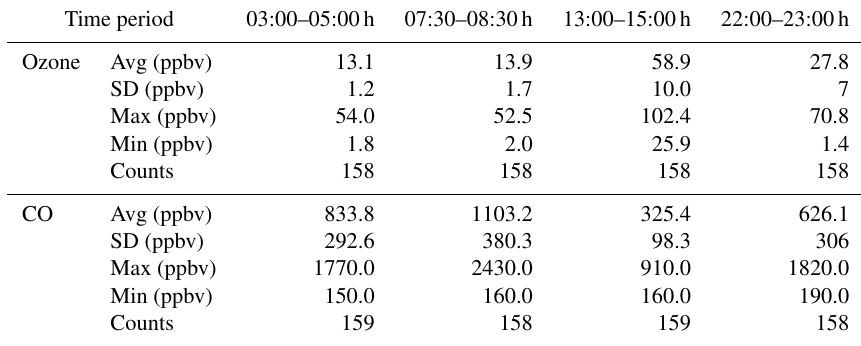
Table 2. Average (avg), standard deviation (SD), maximum (max), minimum (min) and daily counts of O 3 and CO values during four time periods for the entire observational period (January–June 2013).